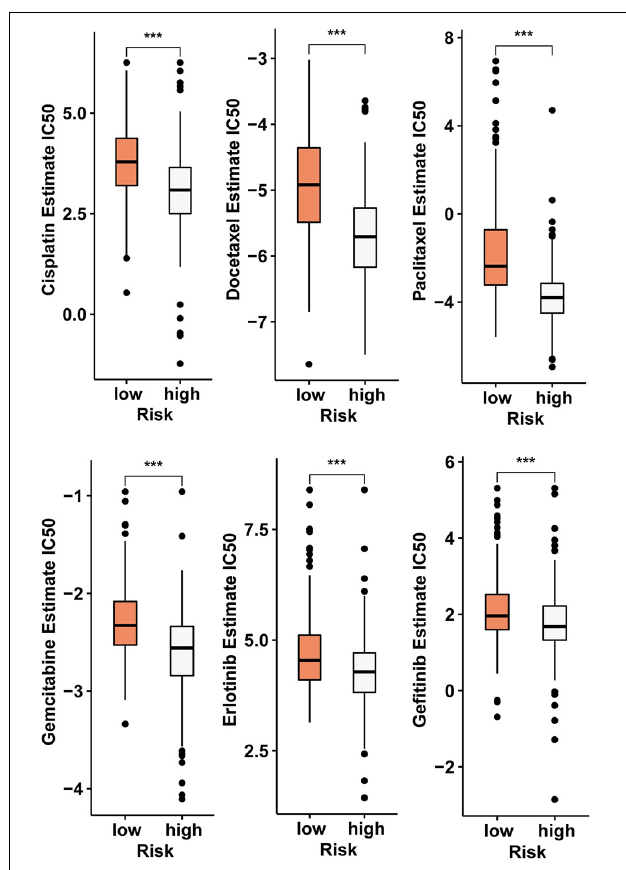
FIGURE 7 | The risk score model serves as a potential predictor of sensitivity to chemotherapy and targeted therapy, as high-risk scores are associated with lower IC 50 of chemotherapy and targeted therapy drugs such as cisplatin, docetaxel, gemcitabine, paclitaxel, erlotinib, and gefitinib (*** p <